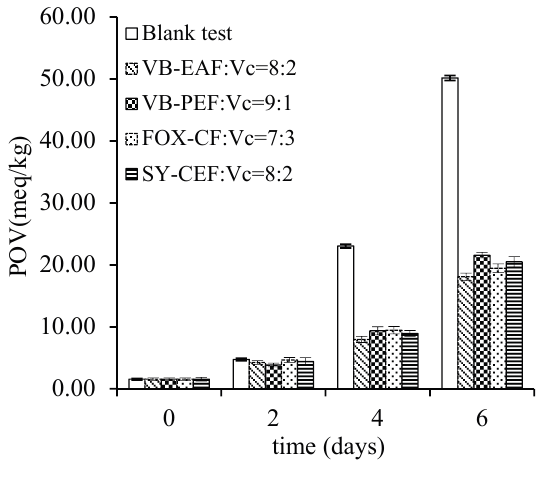
Figure 2. The best synergy of ratios among VB-PEF, FOX-CF, VB-EAF, SY-ME, respectively, with Vc were selected and compared with each other. Storage condition: temperature at 70 ± 1 °C, kept in the dark for 6